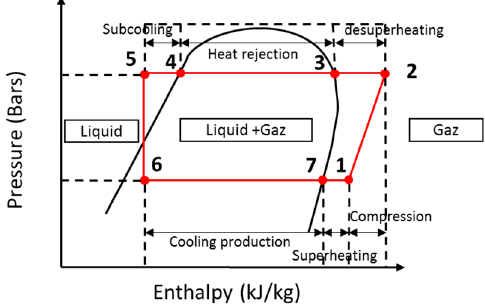
Figure 3. Schematic diagram of the air cooling and heating system: ( a ) compressor—( b ) condenser— ( c ) expansion valve—( d ) evaporator—( e ) moto-ventilator group (MVG)—( f ) ventilation fan. The points 1, 2, 5 & 6 correspond to different thermodynamic states of the refrigerant explained in Figure 4.